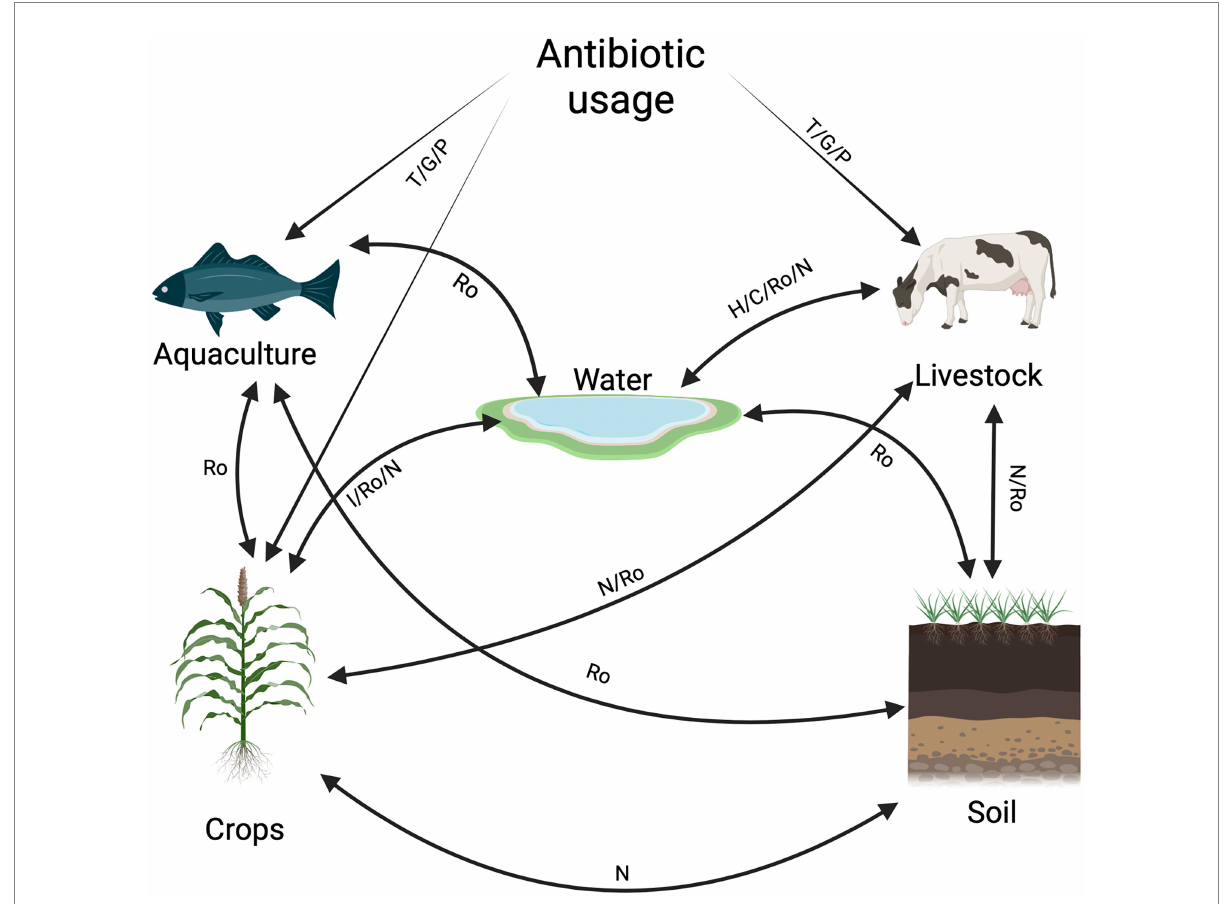
FIGURE 1 Pathway map of antibiotic agents and antibiotic resistance dissemination between livestock, agriculture, aquaculture, and water. The movement of antibiotic resistance or antibiotic agents is indicated by solid lines. The potential routes of transmission and exposure between non-clinical sectors and antibiotic usage is indicated by the abbreviations: Ro: run-off /leaching, T: treatment, P: prevention, GP: growth promoter, H: animal house, C: cleaning, N: nutrients, I: irrigation (Created with BioRender.com). Routes between non-clinical sectors ( ↔ ) and antibiotic usage in non-clinical sectors ( → ) have been described by the previous studies mentioned. Water ↔ crop: (Hu et al., 2010; Gatica and Cytryn, 2013; Meena et al., 2015; Bürgmann et al., 2018; Rodríguez-Molina et al., 2019), water ↔ soil: (Hu et al., 2010; Seiler and Berendonk, 2012; Michael et al., 2013; Meena et al., 2015; Tang, 2016), water ↔ livestock: (Miyata et al., 2011; Hao et al., 2014; Van Boeckel et al., 2015; Magouras et al., 2017; Madec and Haenni, 2018; McEwen and Collignon, 2018; Opatowski et al., 2021), water ↔ aquaculture: (Seiler and Berendonk, 2012; Shah et al., 2014; Grenni et